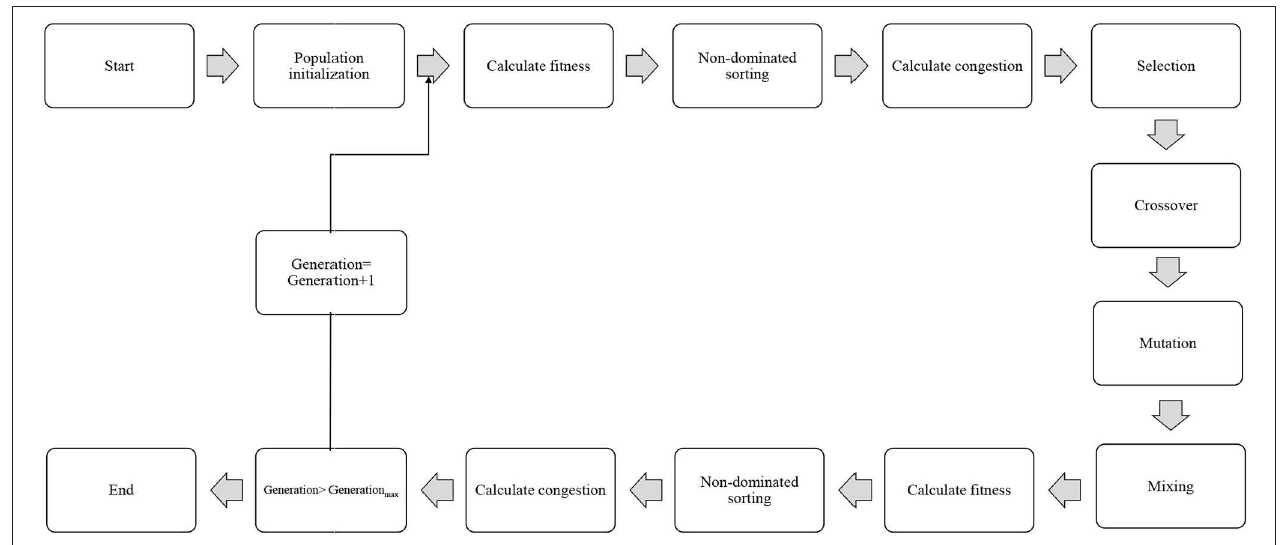
FIGURE 2 | Schematic diagram showing the step-by-step NSGAII optimization process.